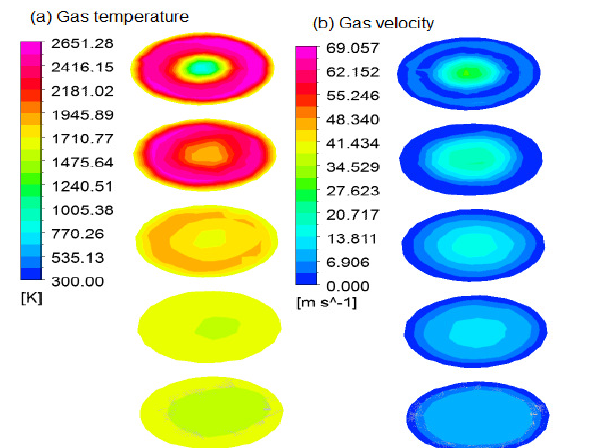
FIG. 2. TEMPERATURE AND VELOCITY CONTOURS AT DIFFERENT PLANES IN THE GASIFIER